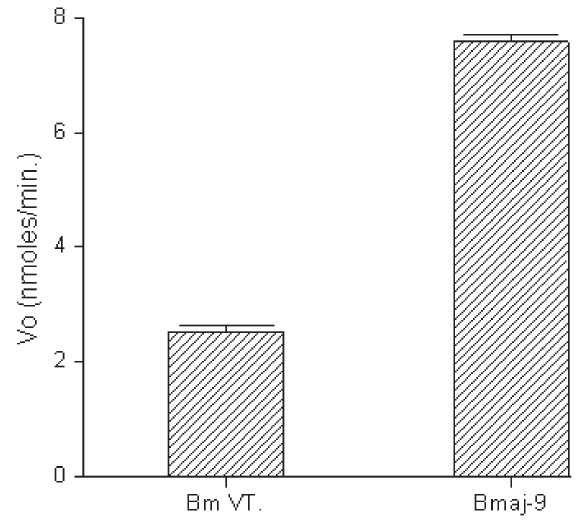
Figure 3. The graphic represents Bmaj-9 PLA enzymatic activity in comparison to B. marajoensis crude venom, indicating a high catalytic activity of the toxin.